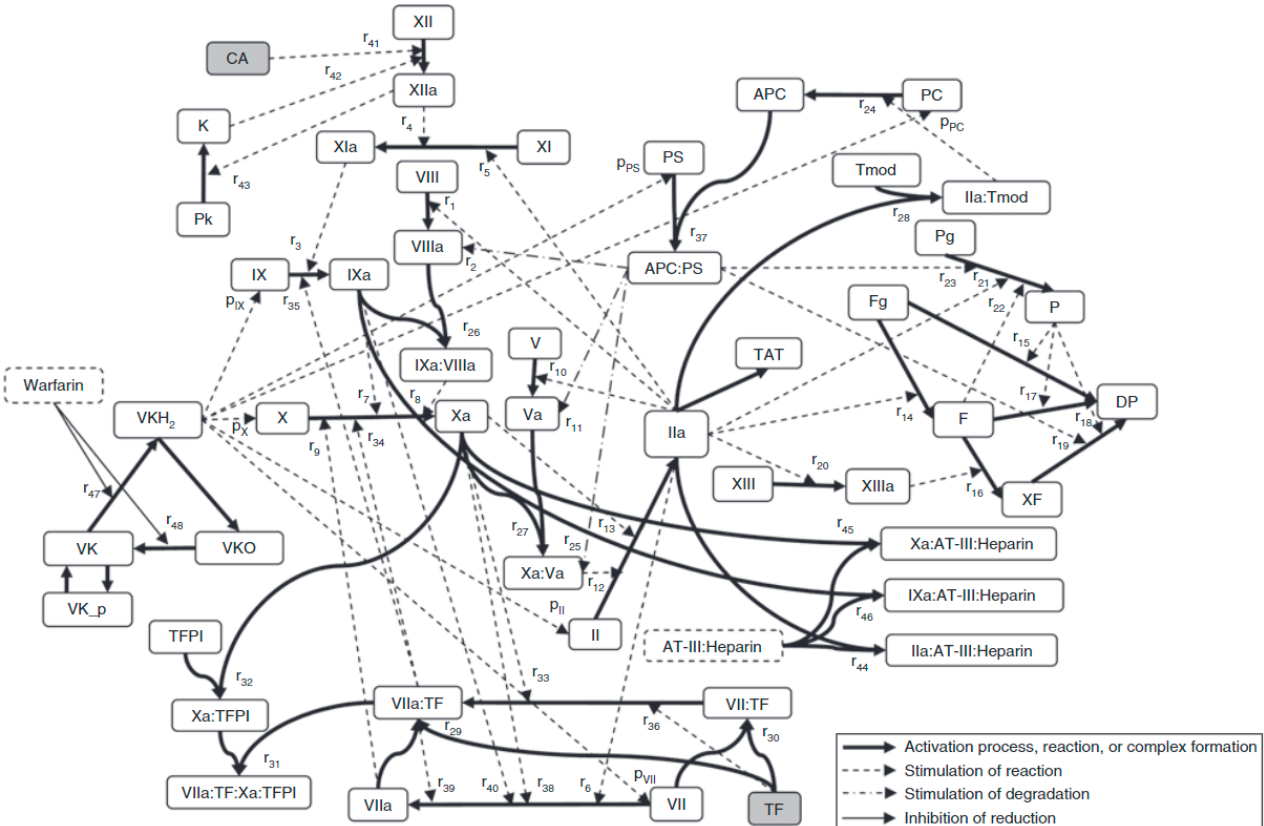
Figure 4. The scheme of the coagulation network model from the Wajima model [6]. The bold solid lines represent the activation process, complex formation, reduction, or oxidization; the broken lines represent stimulation of reaction or production; the dot-bar lines represent stimulation of degradation; the solid lines represent inhibition of reduction. Activated protein C (APC); antithrombin-III (AT-III); activator for the contact system (CA); degradation product (DP); fibrin (F); fibrinogen (Fg); prothrombin (II); thrombin (IIa); prekallikrein (Pk); kallikrein (K); plasmin (P); protein C (PC); plasminogen (Pg); protein S (PS); thrombin–antithrombin complex (TAT); tissue factor (TF); tissue factor pathway inhibitor (TFPI); thrombomodulin (Tmod); vitamin K (VK); vitamin K hydroquinone (VKH2); vitamin K epoxide (VKO); cross-linked fibrin (XF). See original publication [6] for more details on species and reactions.